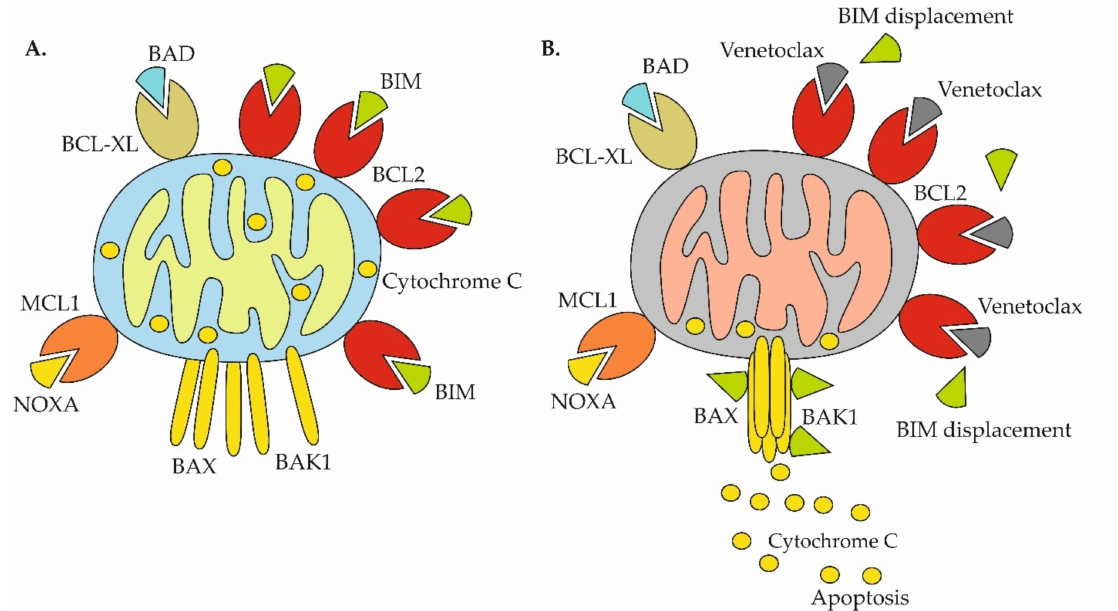
Figure 3. Mechanisms of venetoclax-triggered apoptosis in cells primed for death. ( A ) Cells primed for death: anti- apoptotic BCL2 proteins (BCL2, BCL-XL, MCL1) are fully occupied by pro-apoptotic BH3-only proteins (BIM, BAD, NOXA); ( B ) Venetoclax causes displacement of BIM from BCL2 with subsequent assembly of BAX/BAK1 multiprotein complex, mitochondrial outer membrane permeabilization and release of cytochrome c and activation of